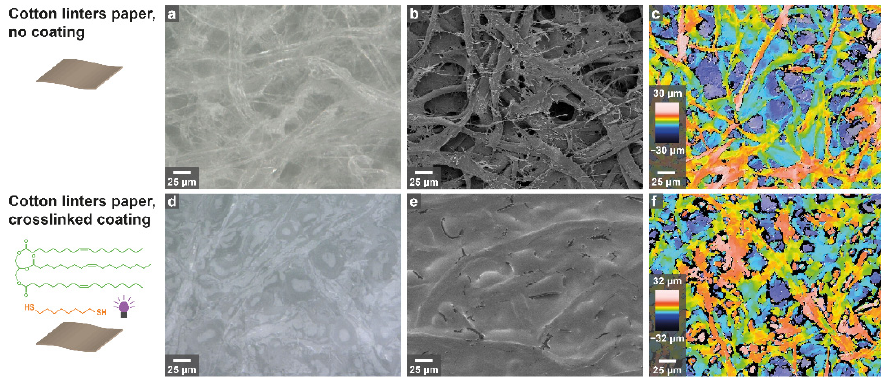
Table 1. Roughness parameters determined from tactile profilometry (profile roughness values) and optical profilometry (surface roughness values).